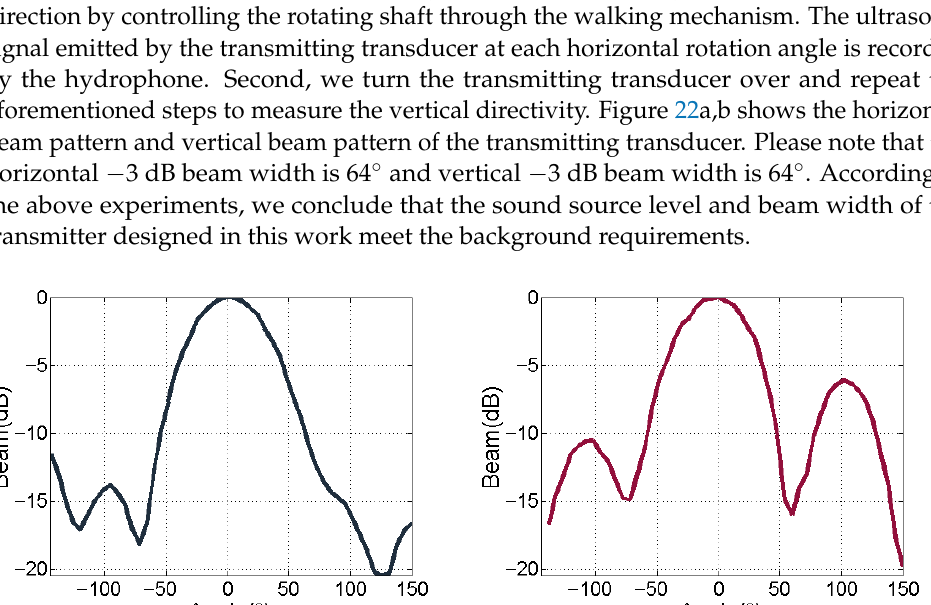
Figure 21. The output ultrasonic signal of standard hydrophone.